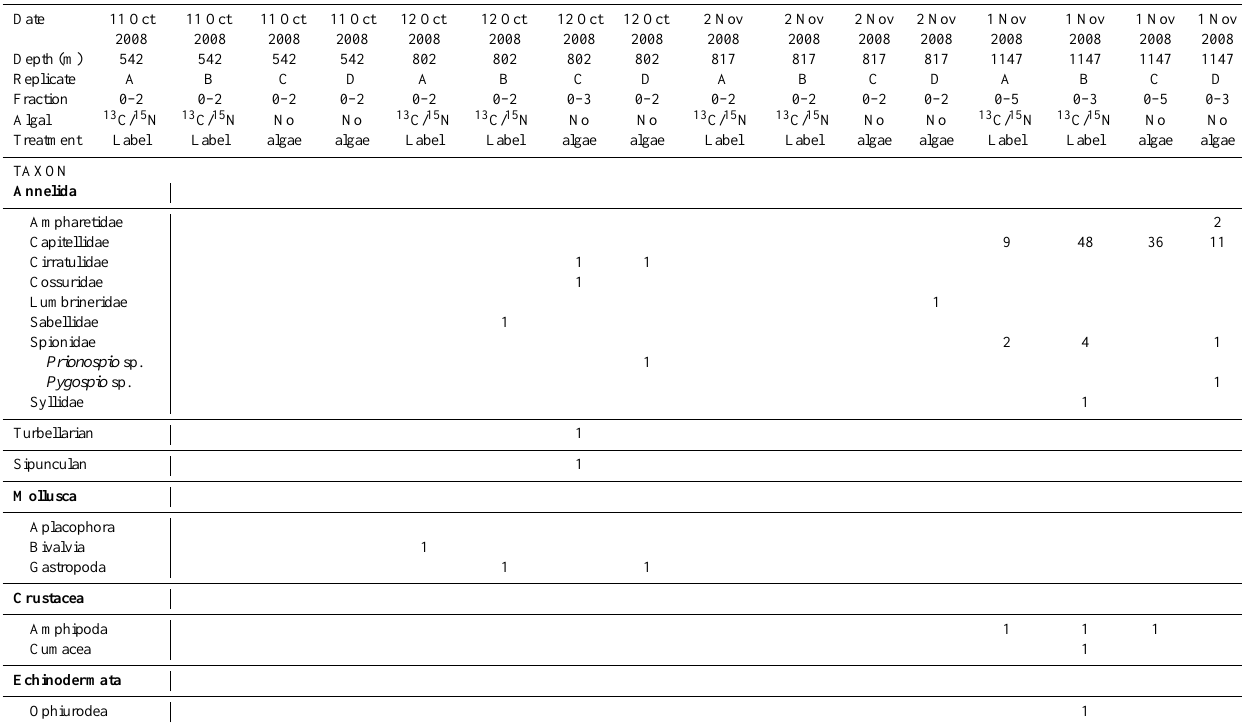
Table 4. Macrofauna colonizing sediment trays deployed on the W. Indian